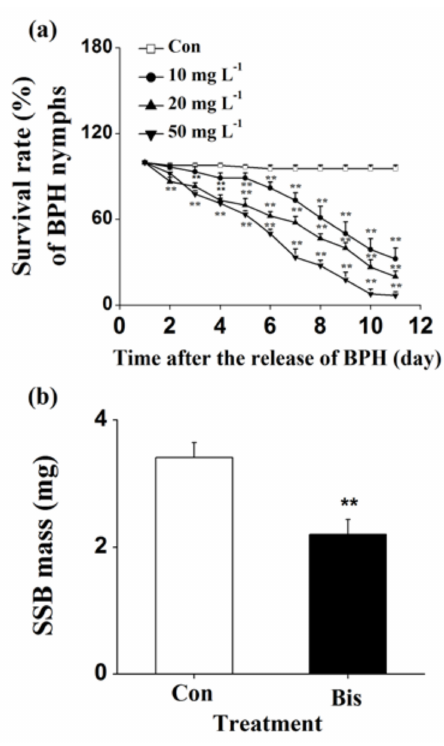
Figure 6. Bismerthiazol induces the resistance of rice to BPH and SSB. ( a ) Mean survival rates (+SE, n = 6) of 15 newly hatched BPH nymphs fed on plants that had been grown in nutrient solution with bismerthiazol (Bis) or without bismerthiazol (Con) for 24 h, 1–11 days after exposure; ( b ) Mean larval mass (+SE, n = 30) of SSB fed for 15 days on plants that had been grown in nutrient solution with 50 mg L − 1 bismerthiazol (Bis) or without bismerthiazol (Con) for 24 h. For BPH data, asterisks indicate significant differences in bismerthiazol-treated plants compared with non-treated plants (** p < 0.01; Duncan’s multiple-range test); for SSB data, asterisks indicate significant differences between members of a pair (** p < 0.01; Student’s t